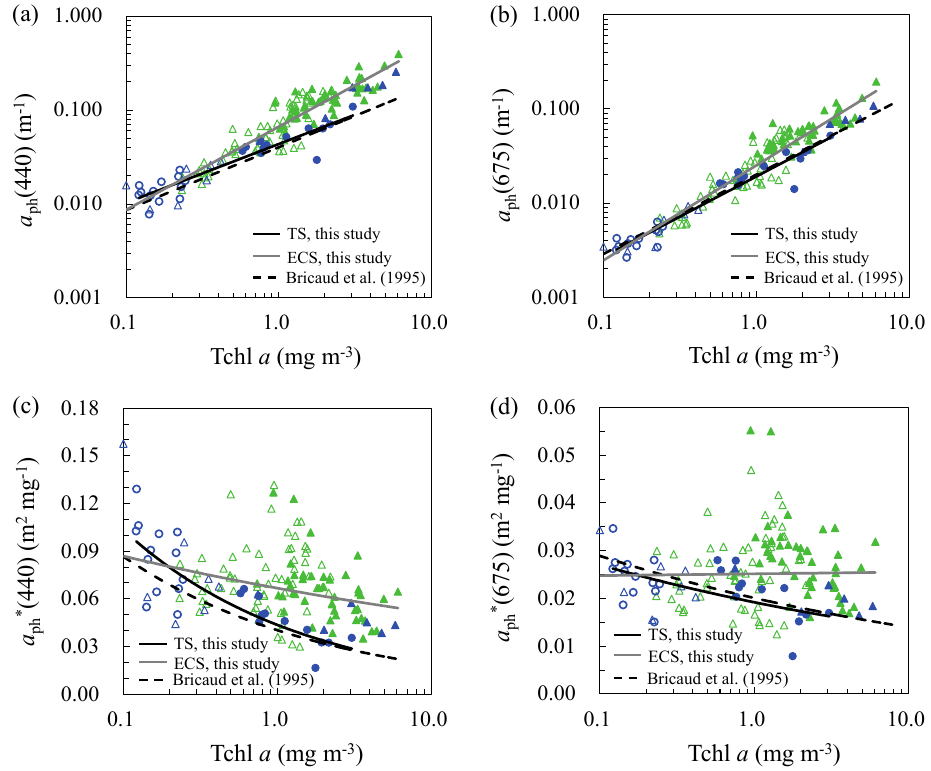
Fig. 3. Correlations between Tchl a and a ph (440) (a) , a ph (675) (b) , a ∗ surface (unfilled circle), Tsushima Strait SCM (filled circle), East China Sea surface (unfilled triangle), and East China Sea SCM (filled triangle). Green symbols indicate samples with a surface salinity <32, and blue symbols indicate samples with a surface salinity >32. Black and grey lines indicate power law functions fitted in the Tsushima Strait (TS) and East China Sea (ECS), respectively. Black dashes correspond to the regressions of Bricaud et al. (1995).